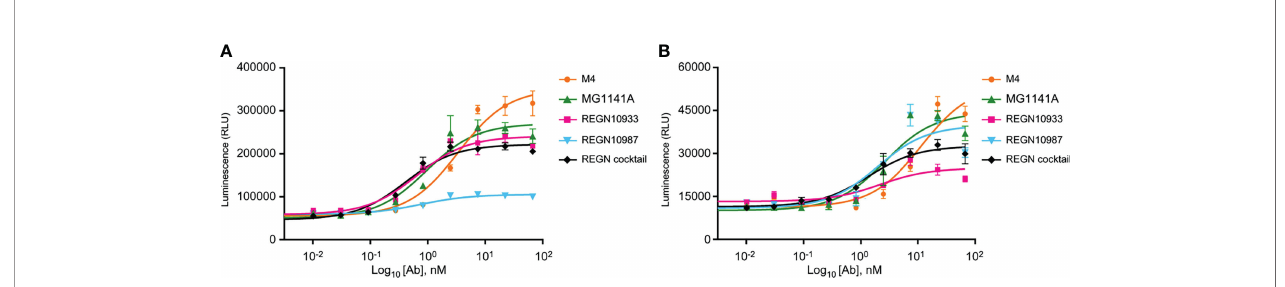
FIGURE 4 | Fc-mediated effector functions of anti-SARS-CoV-2 mAbs. (A) Activation of ADCC signaling was evaluated using a Fc g RIIIa-expressing reporter cell line as effector cells and SARS-CoV-2 S-glycoprotein-expressing HT1080 as target cells. (B) Activation of ADCP signaling was measured using Fc g RIIa-H-expressing reporter cell line as effector cells and SARS-CoV-2 S-glycoprotein-expressing HT1080 as target cells. In (A, B) , bars are mean ± standard error of the mean (SEM) of